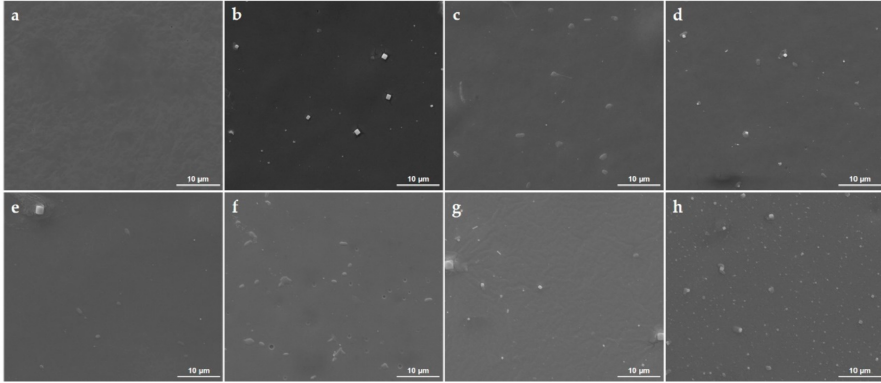
Figure 6. SEM images of initial PLGA/IBUP coating ( a ) and PLGA/IBUP coatings during biologically simulated dynamic testing: 2 ( b ), 4 ( c ), 6 ( d ), 10 ( e ), 15 ( f ), 20 ( g ) and 30 days ( h